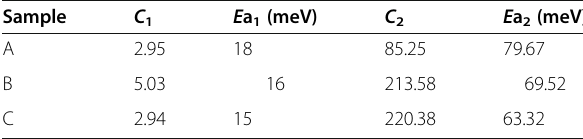
Table 2 Fitting parameters based on Eq. (2) for samples A, B, and C